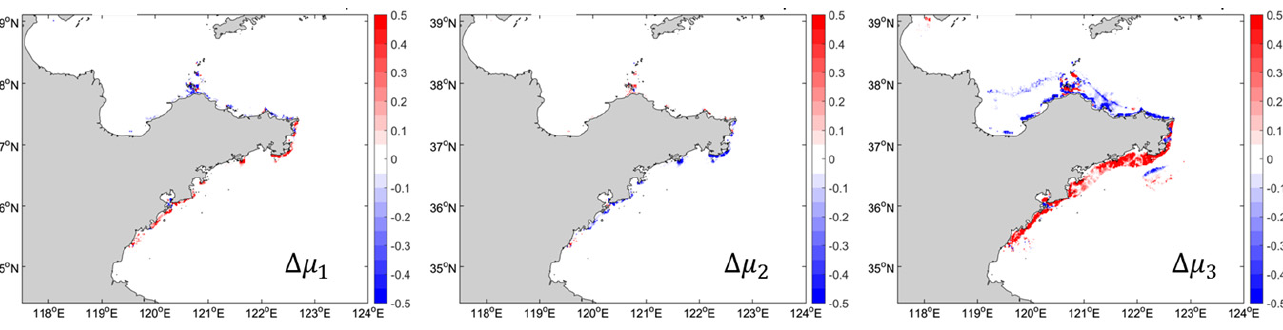
Figure 5. Change of the coastal ocean waves caused by nearshore strengthening effect.